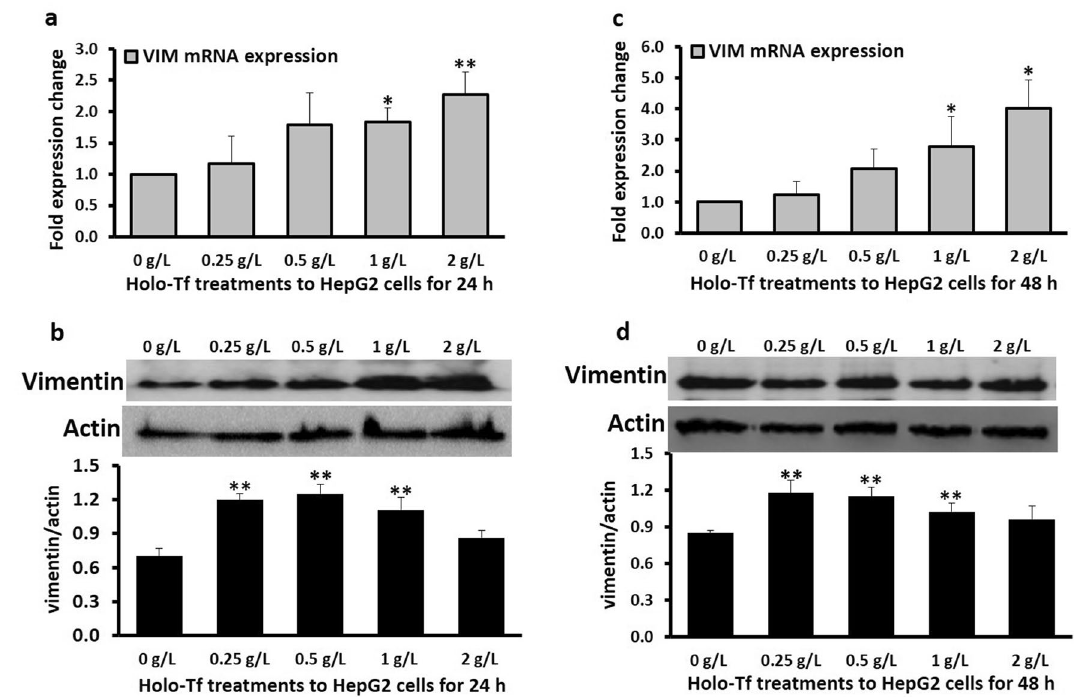
Figure 4. Effect of holo-transferrin on mesenchymal marker vimentin. HepG2 cells were treated with holo-Tf for 24 h ( a , b ) and 48 h ( c , d ). Gene expression of vimentin (VIM) ( a , c ) and levels of vimentin protein ( b , d ) were determined by real-time PCR and western blot, respectively. Images are cropped versions. Full length images are in Supplementary Fig. 3. Protein intensity was analysed by the Image-J software pp available at the National Institute of Health (USA), downloadable from https ://image j.nih.gov/ij/downl oad.html as of August 2020. Data is presented as mean ± SEM (n = 3–4). * < = 0.05 and **< = 0.03 compared to untreated control (0